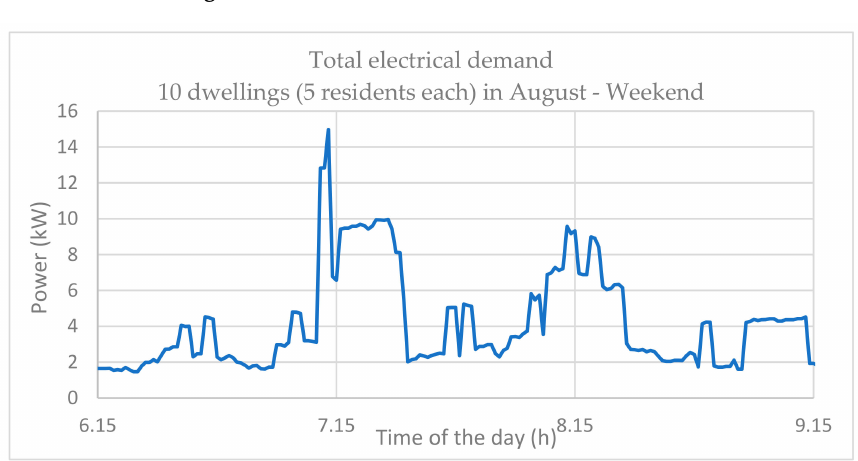
Figure 16. 3 h (06:15–09:15) total electrical demand—Profile